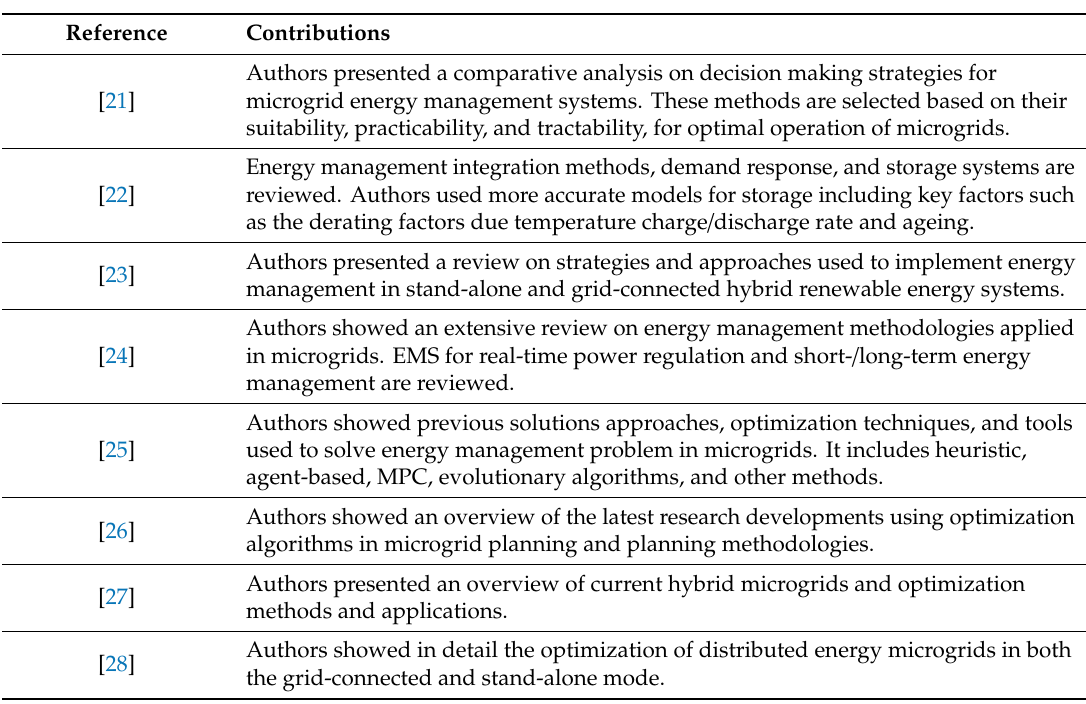
Table 1. Microgrids energy management review